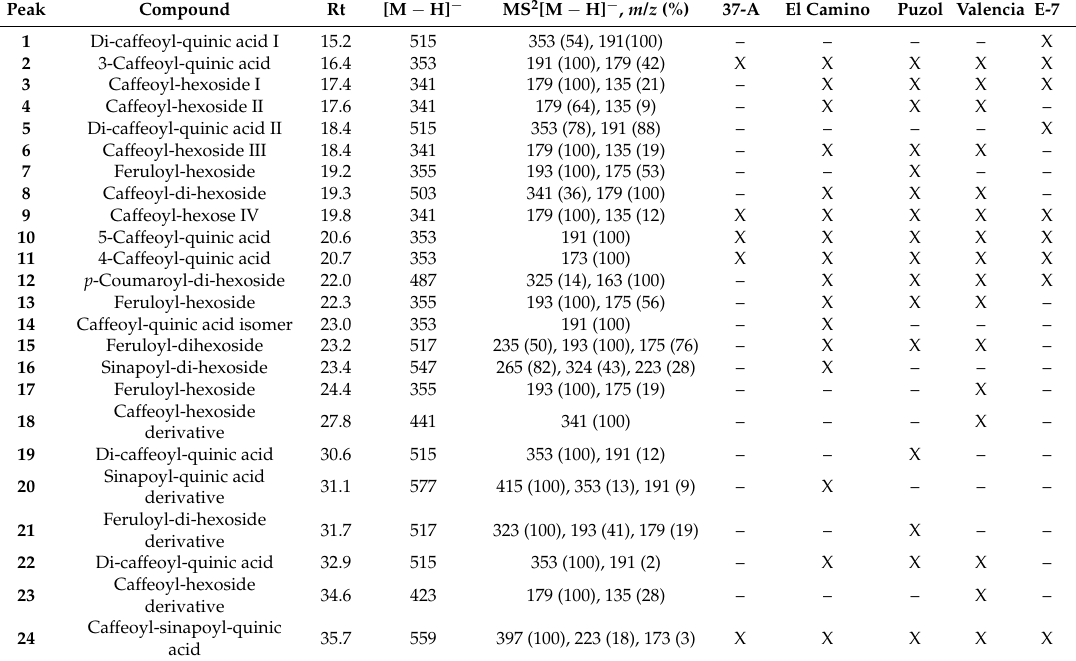
Table 1. Rt, MS: [M ´ H] ´ , MS 2 [M ´ H] ´ and relative abundance (%; calculated based on the intensity of the main base peak in the MS 2 fragmentation pattern, which is considered as 100%) of phenolic compounds identified (marked by an X) in fruit samples of pepino ( S. muricatum ) and its wild relative S. caripense